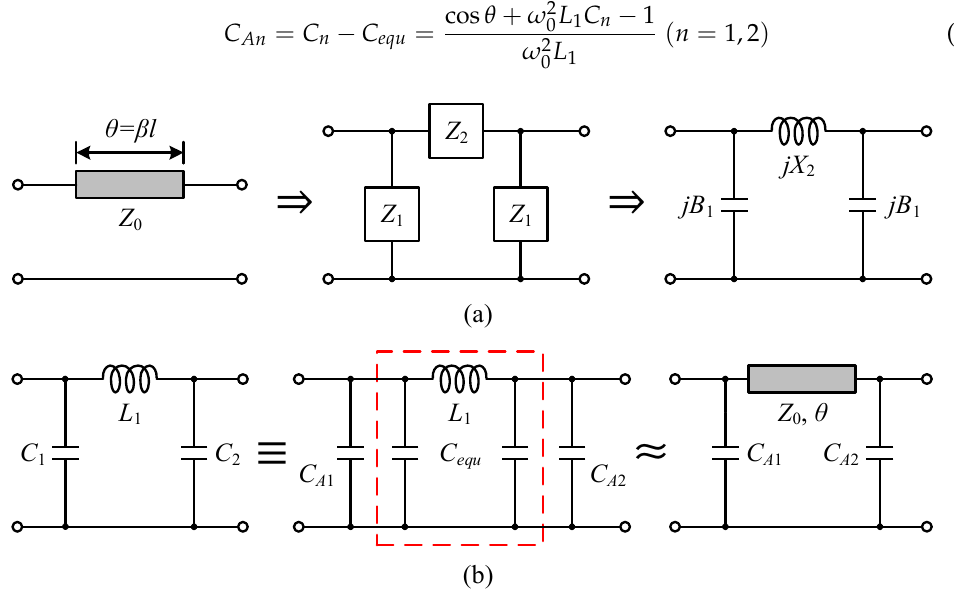
Figure 7. ( a ) Equivalent two-port network of a transmission line. ( b ) Swap an identified lumped low-pass π -section into its almost equivalent mixed-element counterpart using the replacement technique.